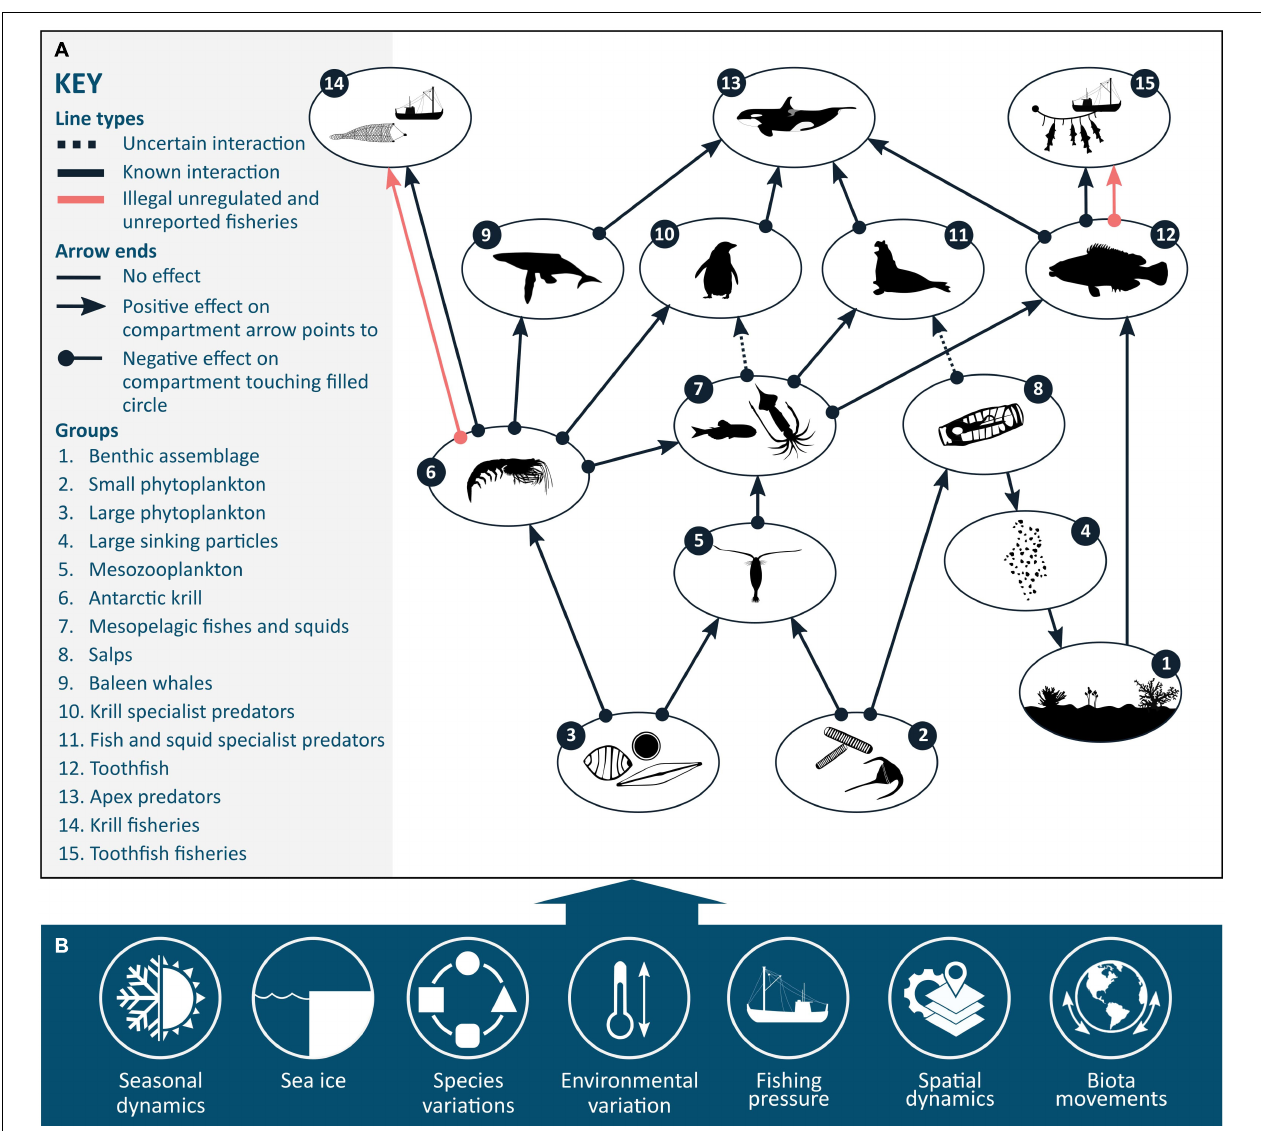
FIGURE 2 | (A) Simplified representation of a Southern Ocean food web, incorporating links to dependent fisheries. (B) Key controls underlying food web dynamics. Figure adapted from Trebilco et al. (2020).